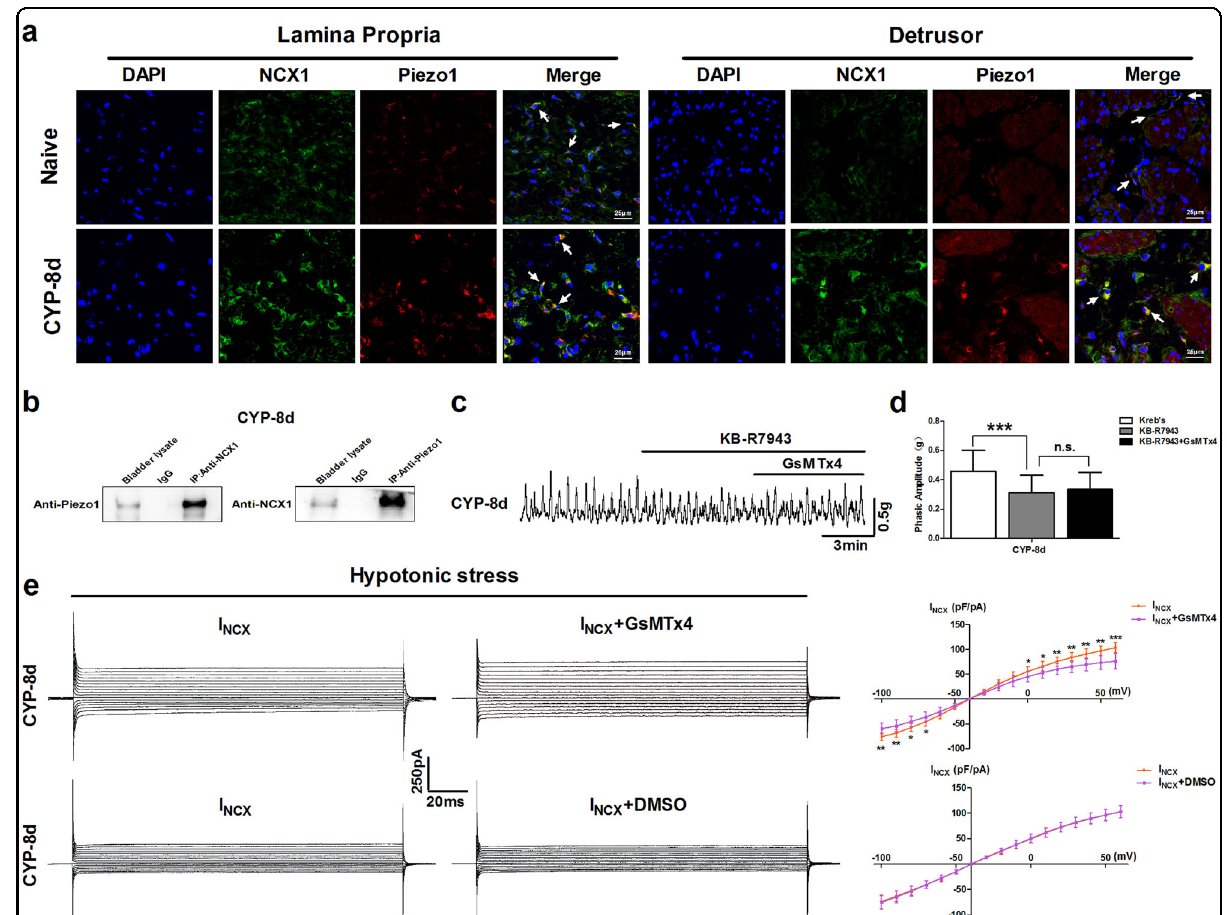
Fig. 6 The Piezo1 channel functionally interacted with reverse NCX1 activity in bladder ICC-LCs from CYP-8d rats. a The IF staining results con fi rmed that the Piezo1 channel (red) was colocalized with NCX1 (green) in cells located in the lamina propria and detrusor region (white arrows) in naive and CYP-8d rat bladders. b The interaction between the Piezo1 channel and NCX1 in bladder lysates extracted from CYP-8d rats was detected by co-IP analysis. c , d An antagonist of NCX reverse mode, KB-R7943 (10 μ M), signi fi cantly eliminated the effects of GsMTx4 on the phasic amplitude of spontaneous contractions in isolated strips from CYP-8d rats (the data represent the mean ± S.D., n = 6; *** P < 0.001, and n.s., no signi fi cance, versus KB-R7943 administration). e I NCX was recorded in bladder ICC-LCs from CYP-8d rats under hypotonic conditions. Compared with DMSO, GsMTx4 signi fi cantly reduced the absolute value of I NCX density. The reduction in the reverse mode of NCX (0 to + 60 mV) was more signi fi cant than that in the forward mode of NCX ( − 100 to − 70 mV) (the data represent the mean ± S.D., n = 8; * P < 0.05, ** P < 0.01, and *** P <